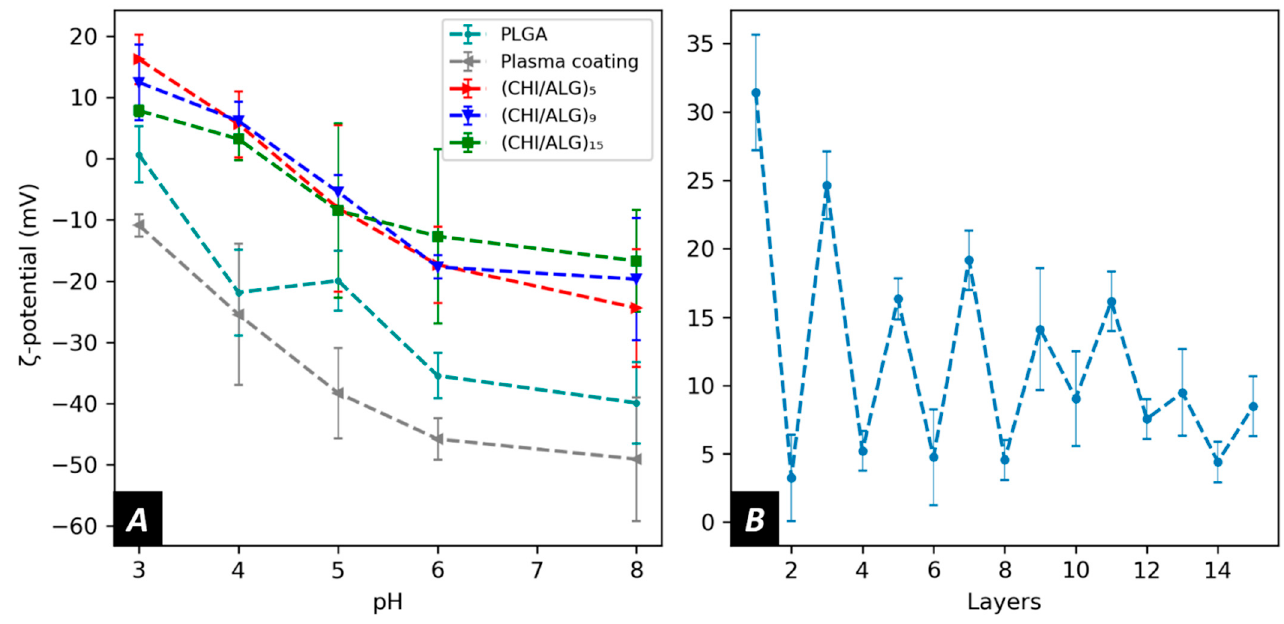
Figure 5. Surface zeta potential of ( A ) PLGA, plasma coated, (CHI/ALG) 5 , (CHI/ALG) 9 , (CHI/ALG) 15 , and ( B ) of the layer deposition process at pH 3.